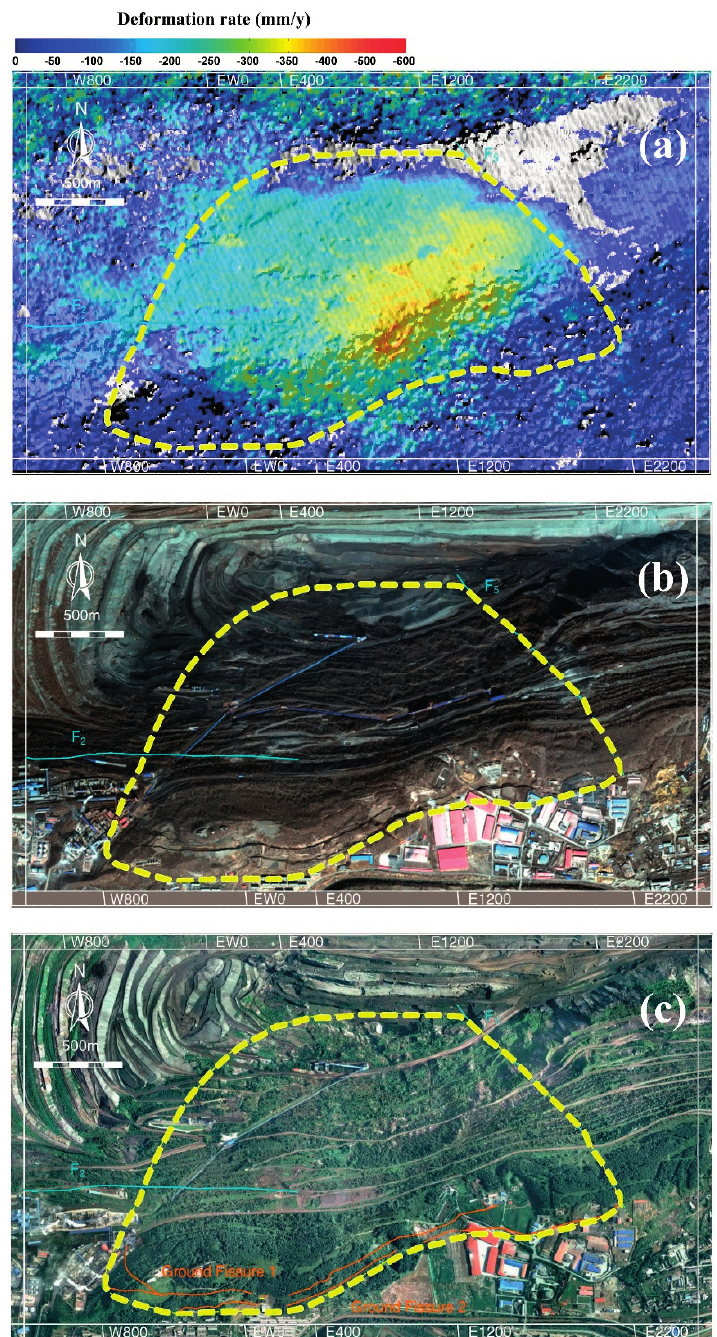
Figure 11. The yellow dashed line marks the boundary of the south landslide in FWOPM [22]. ( a ) The color represents the integrated displacement rate for the studied period. The background is a shaded relief map of SRTM DEM; ( b ) The base image was captured by China’s Gaofen-1 satellite in 2014, several ground fissures can be seen clearly in the south part of FWOPM; ( c ) The base image was an aerial picture of the study area from